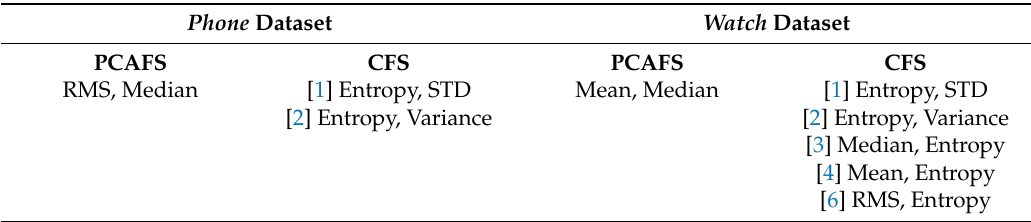
Table 3. Summary of features that were used with the evaluation. PCAFS: Principle component analysis feature selection; CFS: correlation feature selection. STD: standard